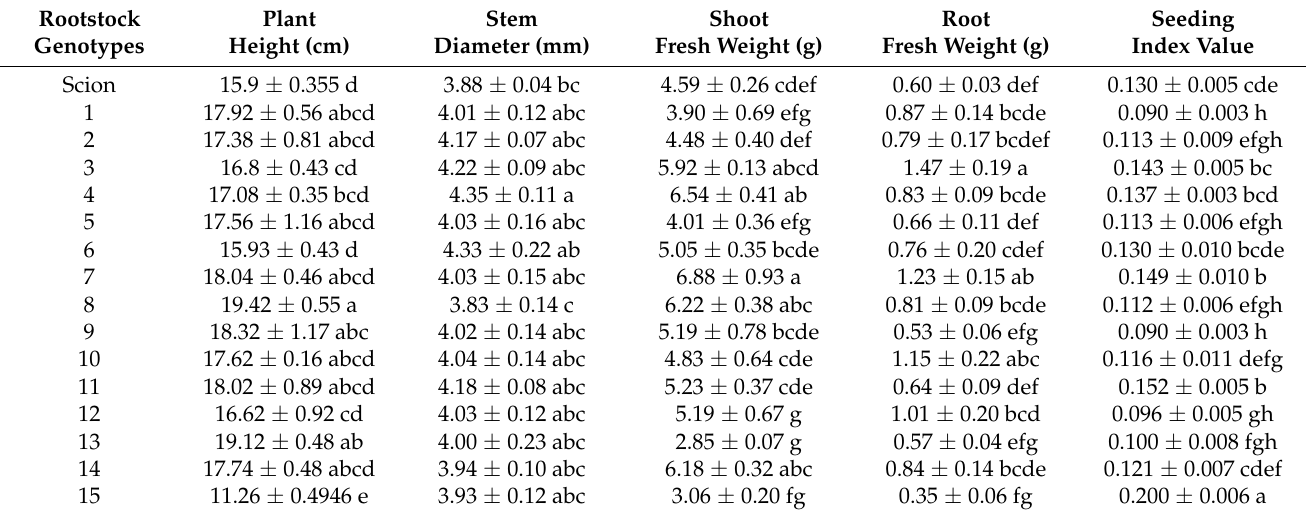
Table 3. Growth parameters of grafted tomatoes with the 15 rootstock genotypes under low- temperature